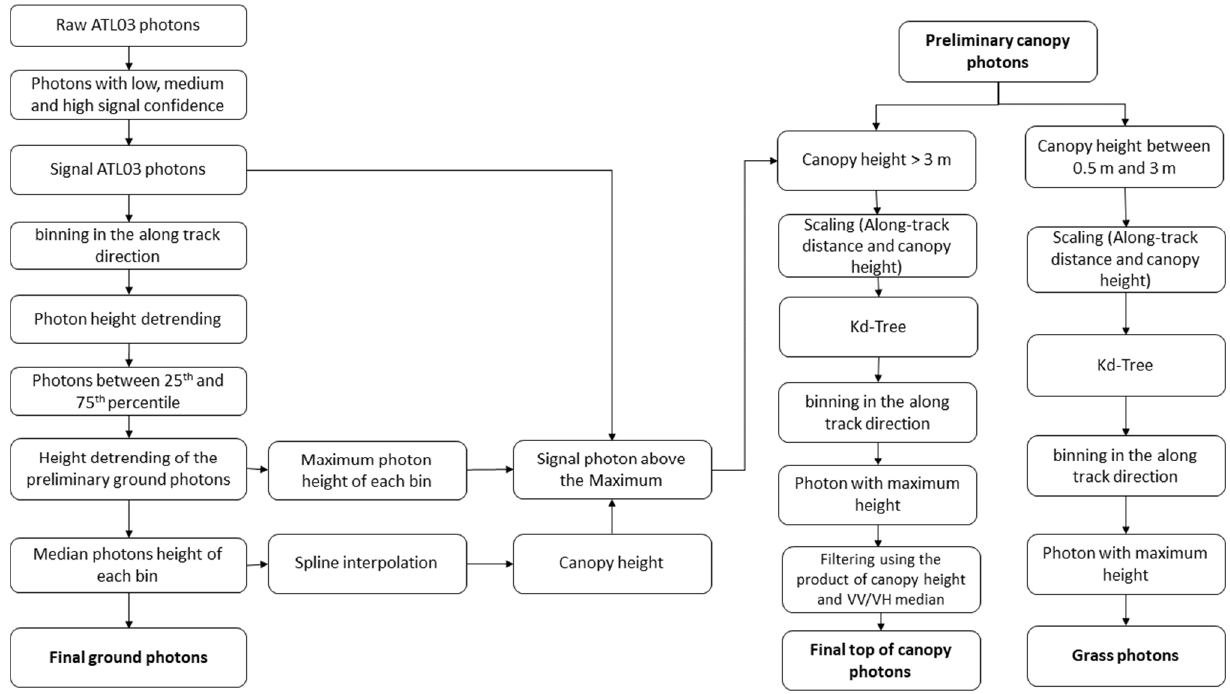
Figure 4. Flowchart of the Sparse Vegetation Detection Algorithm (SVDA) using ICESat-2 ATL03 data.